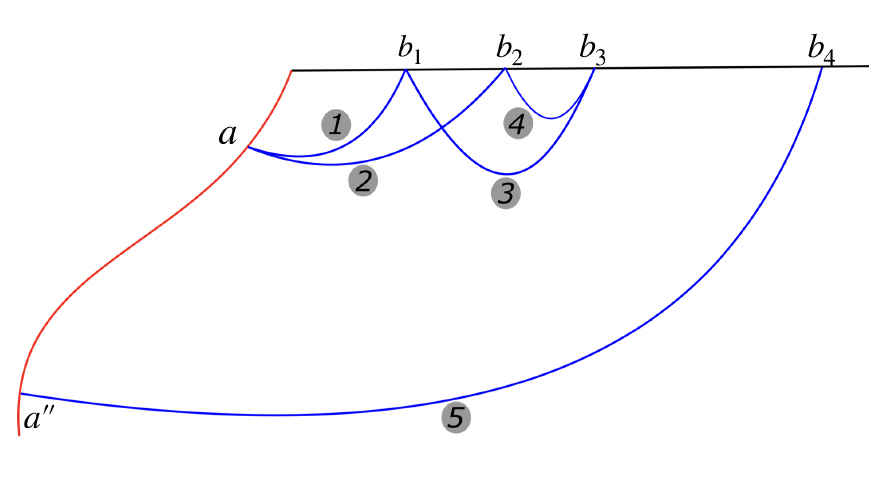
Figure 6: Schematic for the island proposal-I for the entanglement negativity of the mixed state configuration of the disjoint intervals in